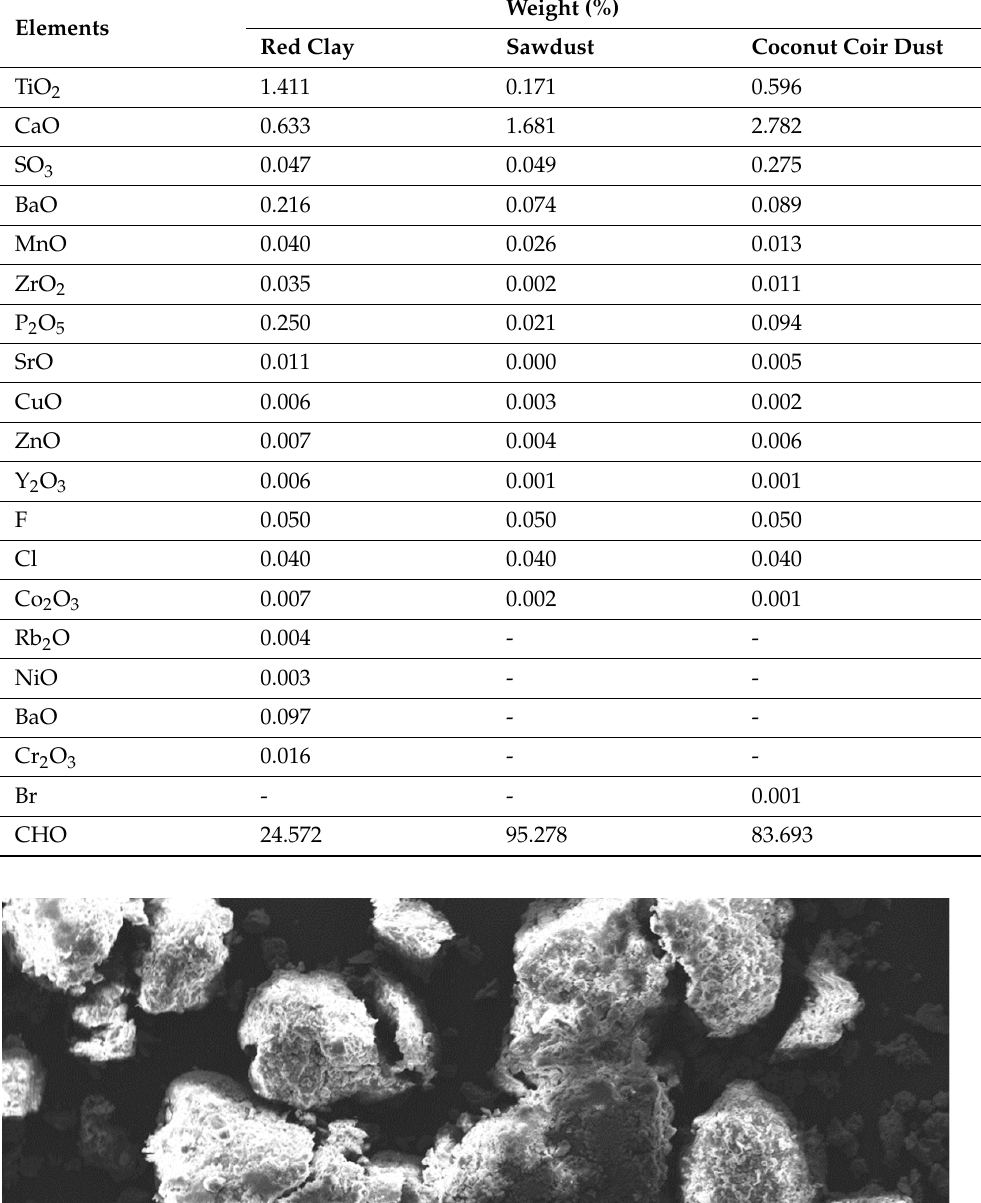
Figure 1. Photographs of raw materials: ( a ) red clay; ( b ) sawdust; ( c ) coconut coir dust.